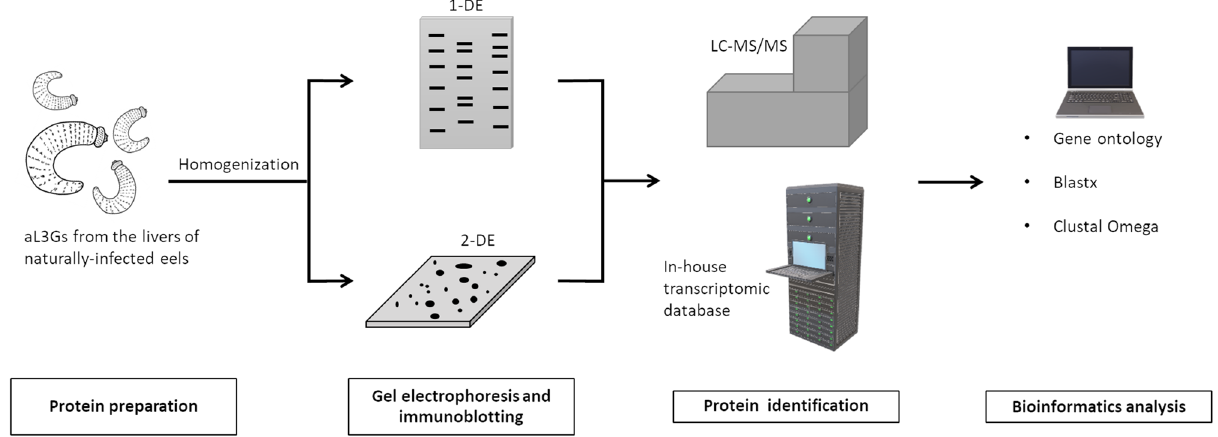
Figure 1. A diagrammatic flowchart summarizing the methods performed in the